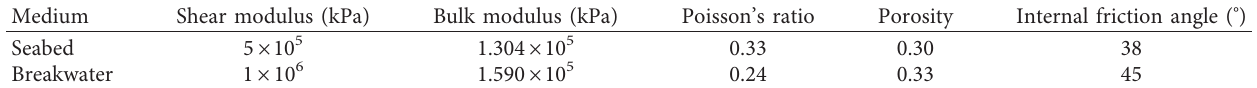
Table 2: Soil properties and wave characteristics in verification